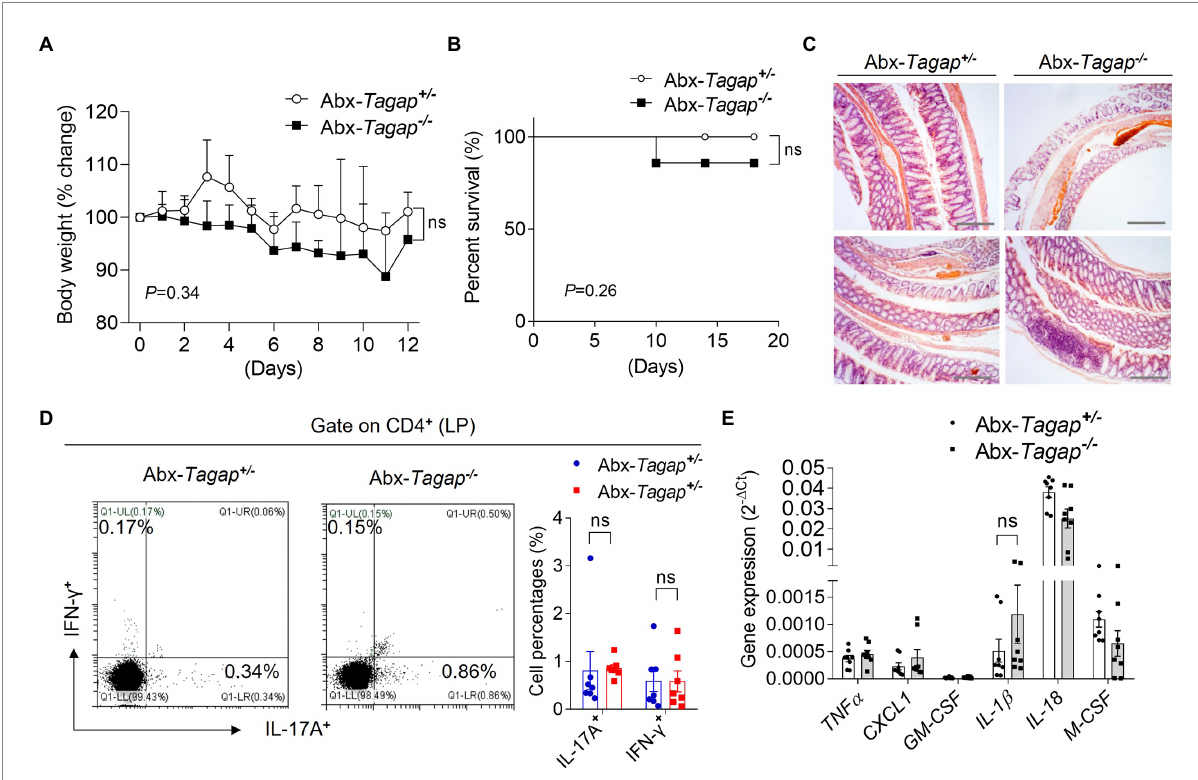
FIGURE 2 Clearance of gut microbiota attenuated DSS-induced colitis severity for TAGAP-deficient mice. (A,B) Littermate control mice or TAGAP-deficient mice were pretreated antibiotics for 2 weeks as described in the Method, followed by 3% of DSS treatment for 7 days, and then changed to normal water. Mice weight curve (A) and survival curve (B) were done in separate experiments, n = 9. (C) Mice were treated as in A, and hematoxylin staining of transversal sections of colon sample at day 7 was shown. Scale bar: 150 μ m. (D) Mice were treated as in A, and cells were isolated from lamina propria of control mice or TAGAP-deficient mice after DSS treatment for 5 days, followed by flow cytometry analysis of CD4 + IL-17A + and CD4 + IFN- γ + cells, n = 7. (E) Mice were treated as in A, and colonic samples were isolated from control mice or TAGAP-deficient mice, followed by real-time PCR analysis for the indicated genes, n = 8. * p < 0.05, ** p < 0.01, *** p < 0.001, **** p < 0.0001 based on two-way ANOVA (A) and Log-rank (Mantel-Cox) Test for panel (B) . All error bars represent SEM of technical replicates. Data are representative of three independent